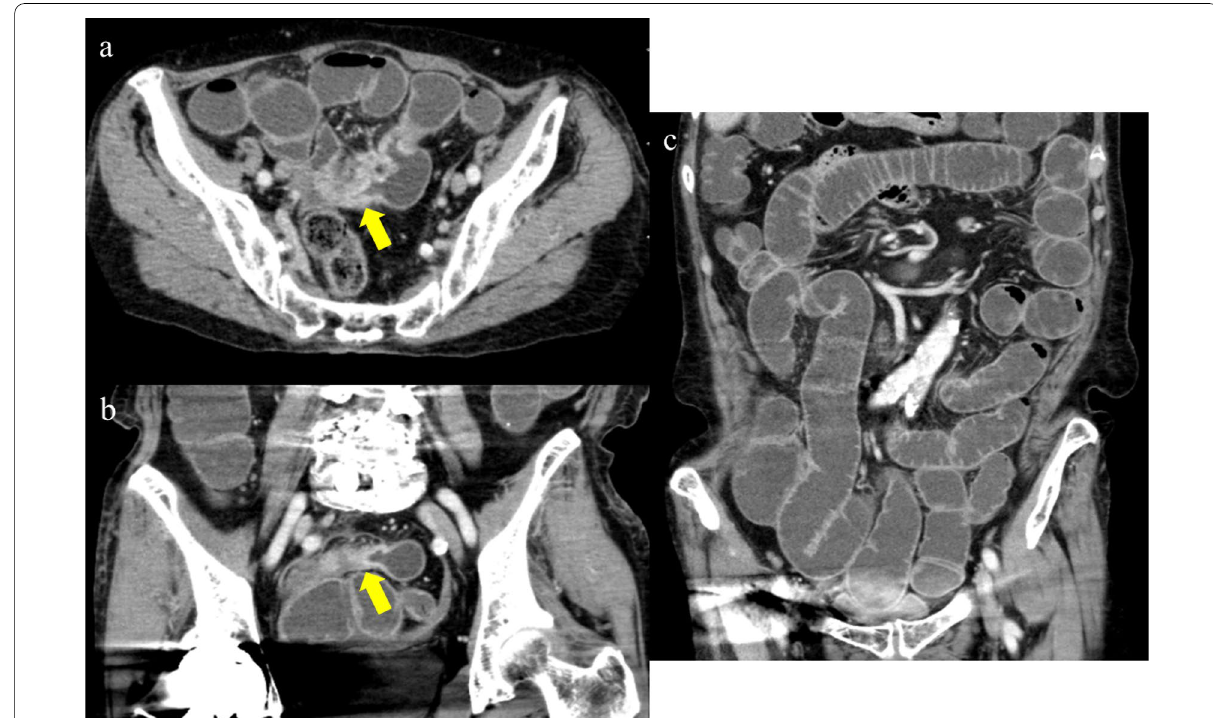
Fig. 1 Abdominal CT findings. CT images revealed wall thickening and stricture of the small bowel (arrow) and fat stranding around the lesion ( a axial view, b coronal view). A wide range of small bowel distension and fluid accumulation in the lumen were observed, showing small bowel obstruction ( c ). There were no specific findings indicating disorder of blood circulation or any characteristics, such as calcification over the mesenteric veins and the bowel